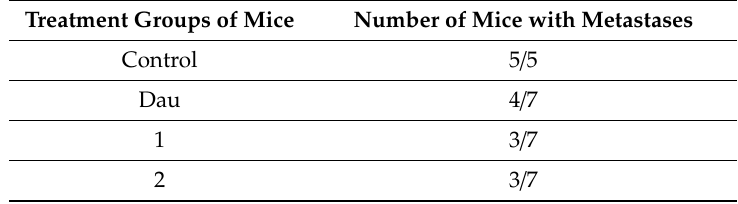
Figure 6. E ff ect of GnRH-III-Dau conjugates 1 and 2 (15 mg / kg Dau content, 6 treatments; 7.5 mg / kg Dau content of each conjugate, respectively, 1 treatment, black arrows) and free Dau (1 mg / kg, 4 treatments, red arrows) in orthotopic MDA-MB-231 human breast carcinoma bearing mice. ( A ) Animal body weight (grams, average ± SD). ( B ) Tumor volume (mm 3 , average ± SD). ( C ) Tumor weight (grams, average ± SD) after termination of the experiment, 45 days subsequent to cell inoculation. ( D ) Liver weight / body weight ratio (percentage, average ± SD) after termination of the experiment, 45 days after cell inoculation, 7 animals per group, statistical analysis was performed by Mann–Whitney test. *, ** and *** mean significant at p < 0.05, p < 0.01 and p < 0.001, respectively. * blue, red, and purple mean significant di ff erence in control, Dau, and 1 groups, respectively, at the end of experiment compared to the start ( A ), and significant di ff erence compared to control, Dau, and 1 groups respectively ( B – D ). Table 2. Anti-metastatic e ff ect of free Dau and GnRH-III conjugates 1 and 2 in orthotopic MDA-MB-231 human breast carcinoma bearing mice on number of animals with metastases close to the primary tumor. Treatment Groups of Mice Number of Mice with Metastases